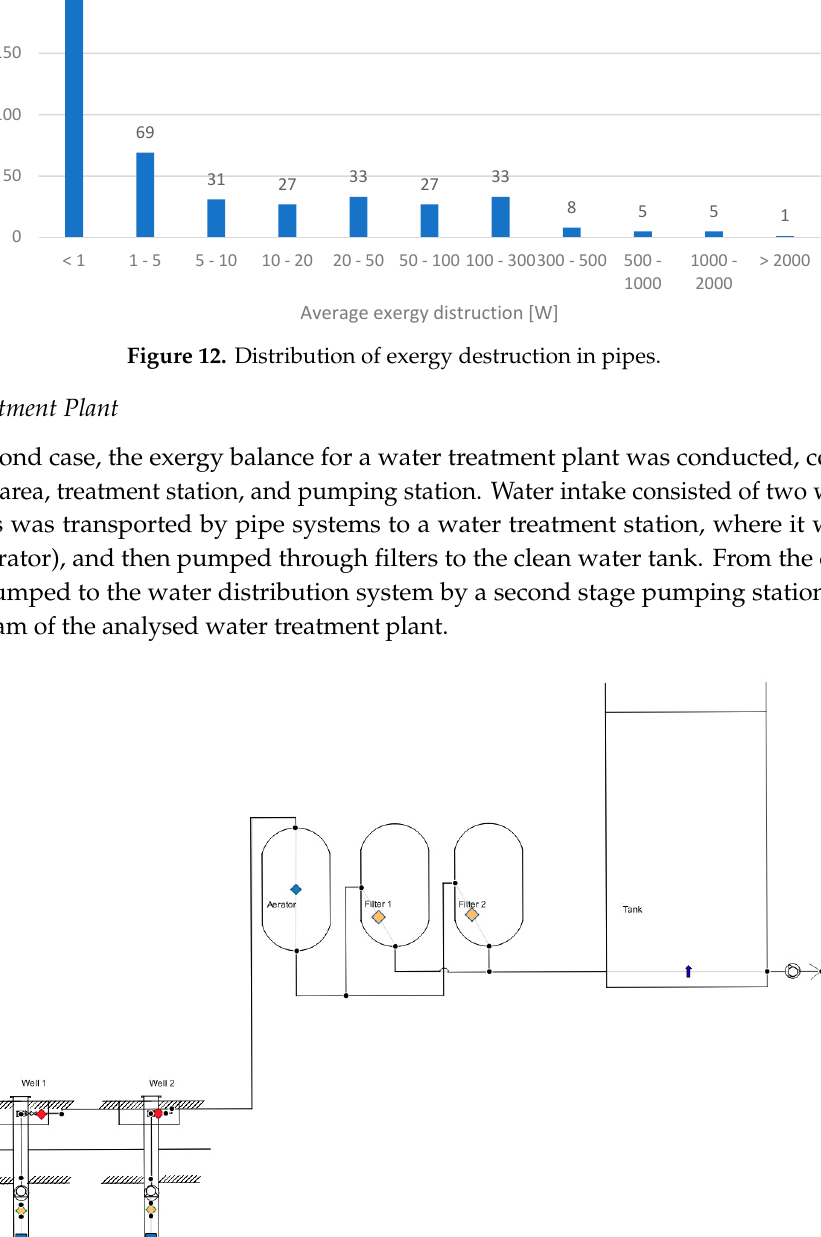
Figure 11. Distribution of exergy destruction in nodes.